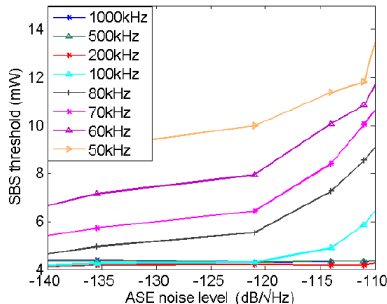
Figure 8. The evolution of the experimental average SBS threshold versus ASE noise levels with different repetition rates. The pulse duration of the optical pulses is 200 ns.